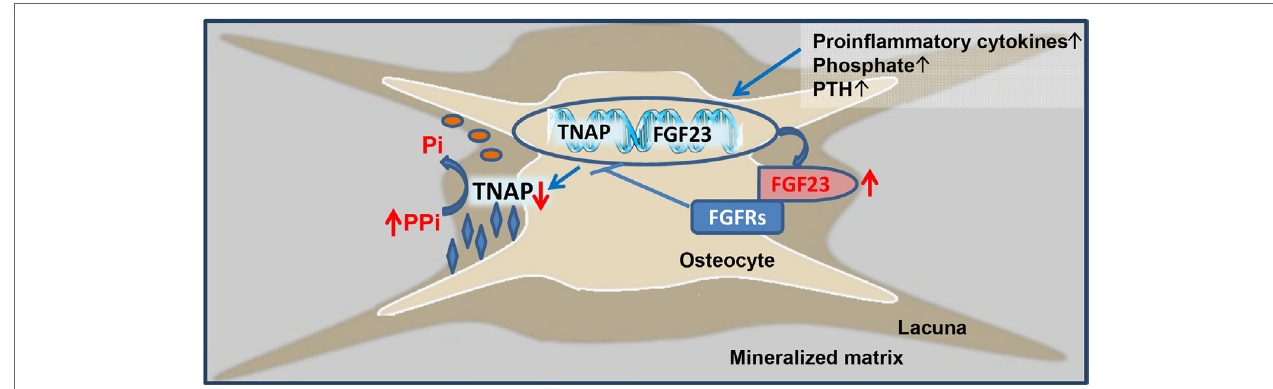
FigUre 6 | Proposed model of fibroblast growth factor-23 (FGF23)-induced suppression of tissue nonspecific alkaline phosphatase (TNAP) and accumulation of pyrophosphate in chronic kidney disease (CKD). Driven by increased circulating concentrations of pro-inflammatory cytokines, phosphate, parathyroid hormone (PTH), and other unknown factors, osteoblastic and osteocytic FGF23 secretion is increased in CKD. Excessive concentrations of FGF23 in the extracellular fluid surrounding osteocytes lead to FGF receptor (FGFR)-mediated, Klotho-independent suppression of TNAP transcription in a para-/autocrine manner. One of the main functions of TNAP in the mineralization process is the hydrolysis of the mineralization inhibitor pyrophosphate (PPi), thus providing inorganic phosphate (Pi) for mineralization. Hence, excessive FGF23 concentrations in the osteocyte canalicular network lead to accumulation of PPi and inhibition of bone mineralization in